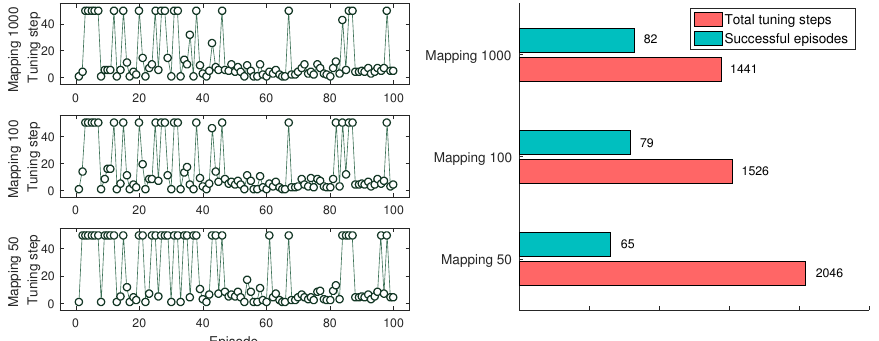
Figure 12. Performance of the transfer framework. ( Left ) Test tuning steps of the three mapping models trained with 1000, 100, and 50 data pairs. ( Right ) Bar charts quantitatively show the results of the three mapping